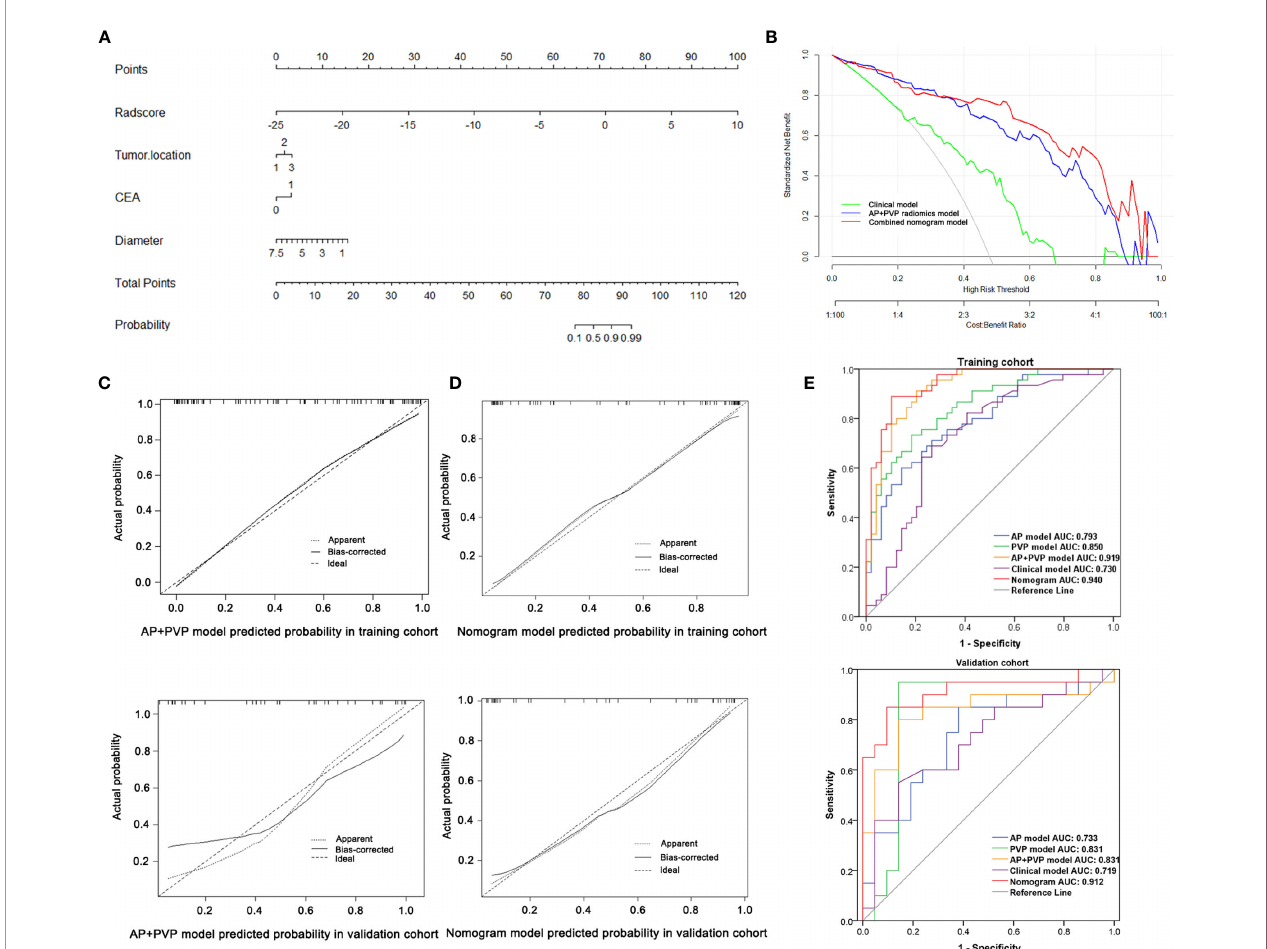
FIGURE 5 | Performance of the combined nomogram and radiomics models. (A) Combined nomogram based on three clinical predictors and the AP+PVP radiomics signature. (B) Decision curve of the combined nomogram. (C) Calibration curve of the AP+PVP radiomics model in the training and validation cohorts. (D) Calibration curve of the combined nomogram in the training and validation cohorts. (E) ROC curves of the AP, PVP, AP+PVP, clinical, and combined nomogram models in the training and validation cohorts. AP, arterial phase; PVP, portal vein phase; ROC, receiver operating